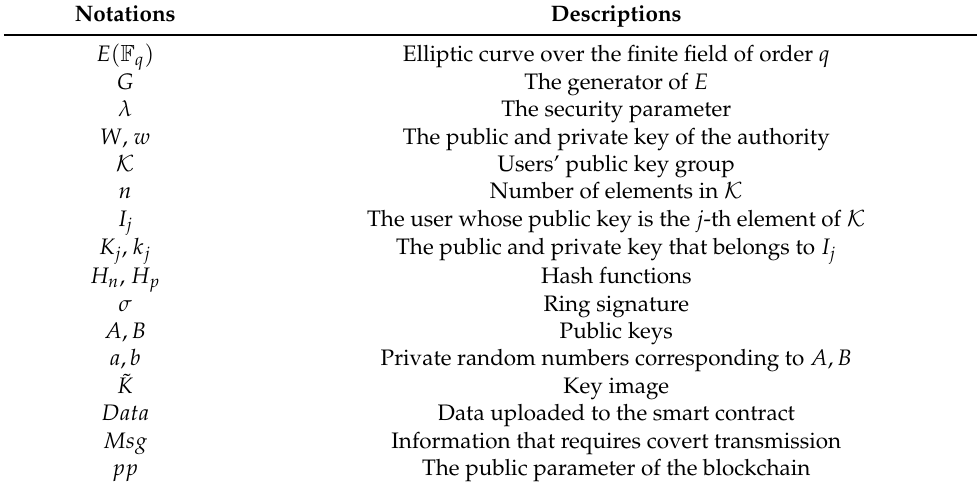
Table 1. Main notations and